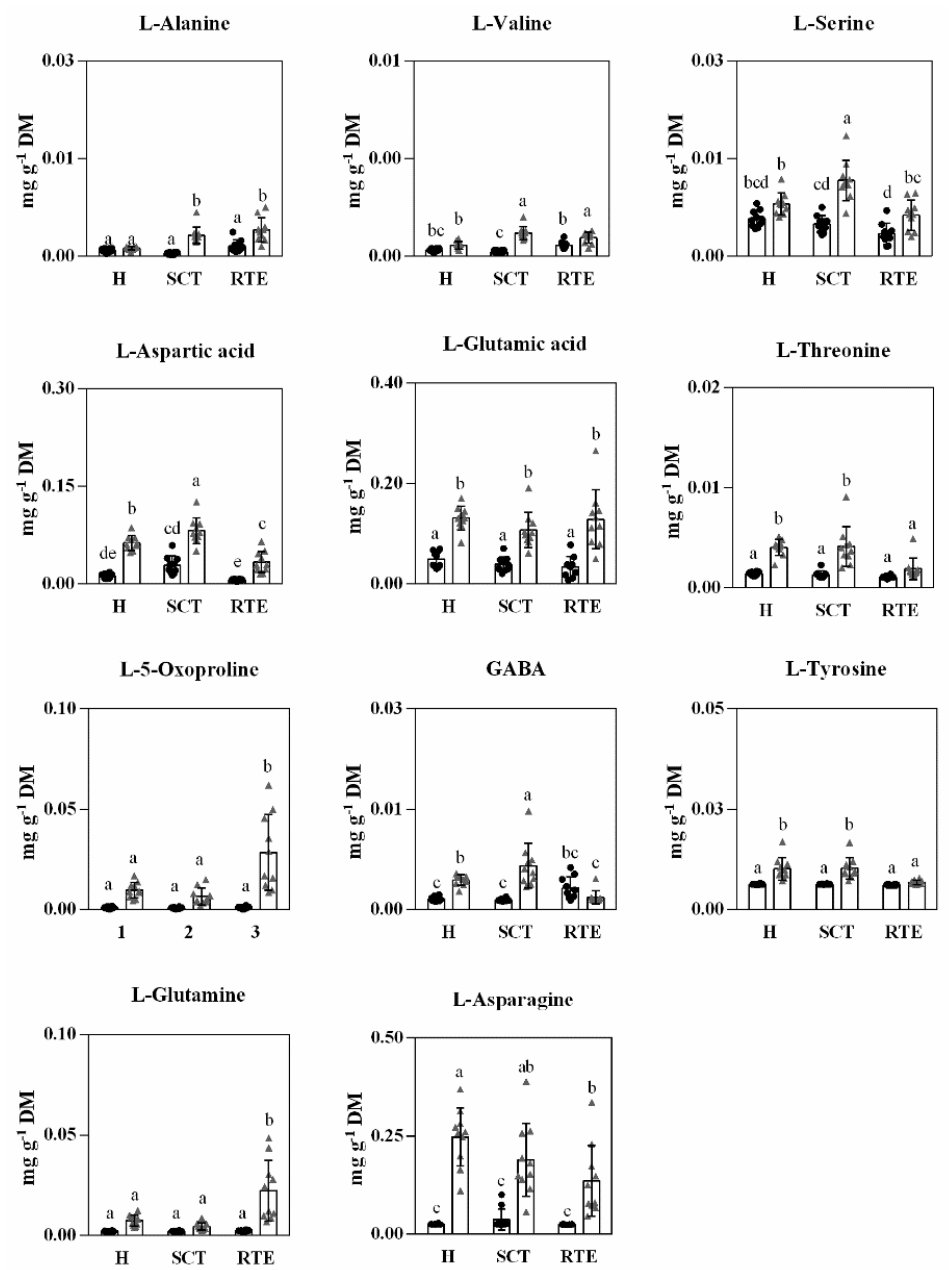
Figure 6. Abundance of amino acids in Hass avocado from two countries, Spain (black dots) and Chile (gray triangle) at harvest (H), after supply chain type (SCT) and at the ready-to-eat stage (RTE). Each column represents an average of 10 biological replicates and the standard deviation (SD) is represented by bars. Different letters indicate significant differences ( p < 0.05) determined by an ANOVA followed by Tukey test.